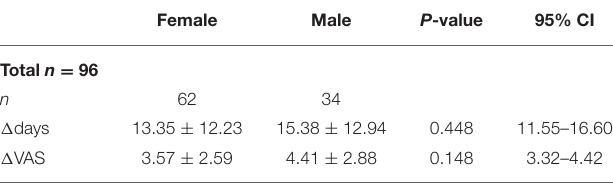
TABLE 5 | Divided by sex with changes in the frequency ( 1 days) and intensity of headaches ( 1 VAS) in group of surgical intervention after a long-term follow-up.